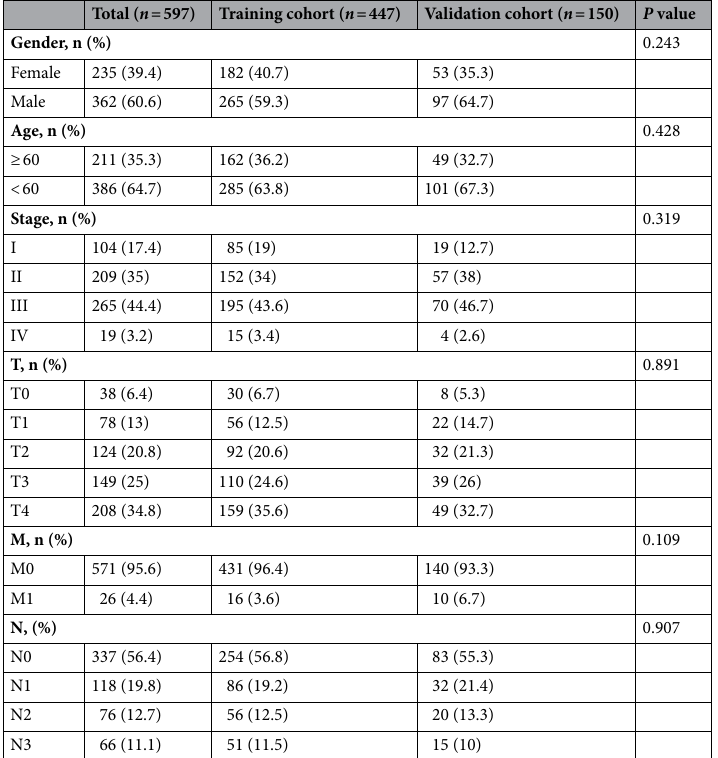
Table 1. Comparison of clinical characteristics between the training and validation cohorts. T tumor stage, N lymph node, M distant